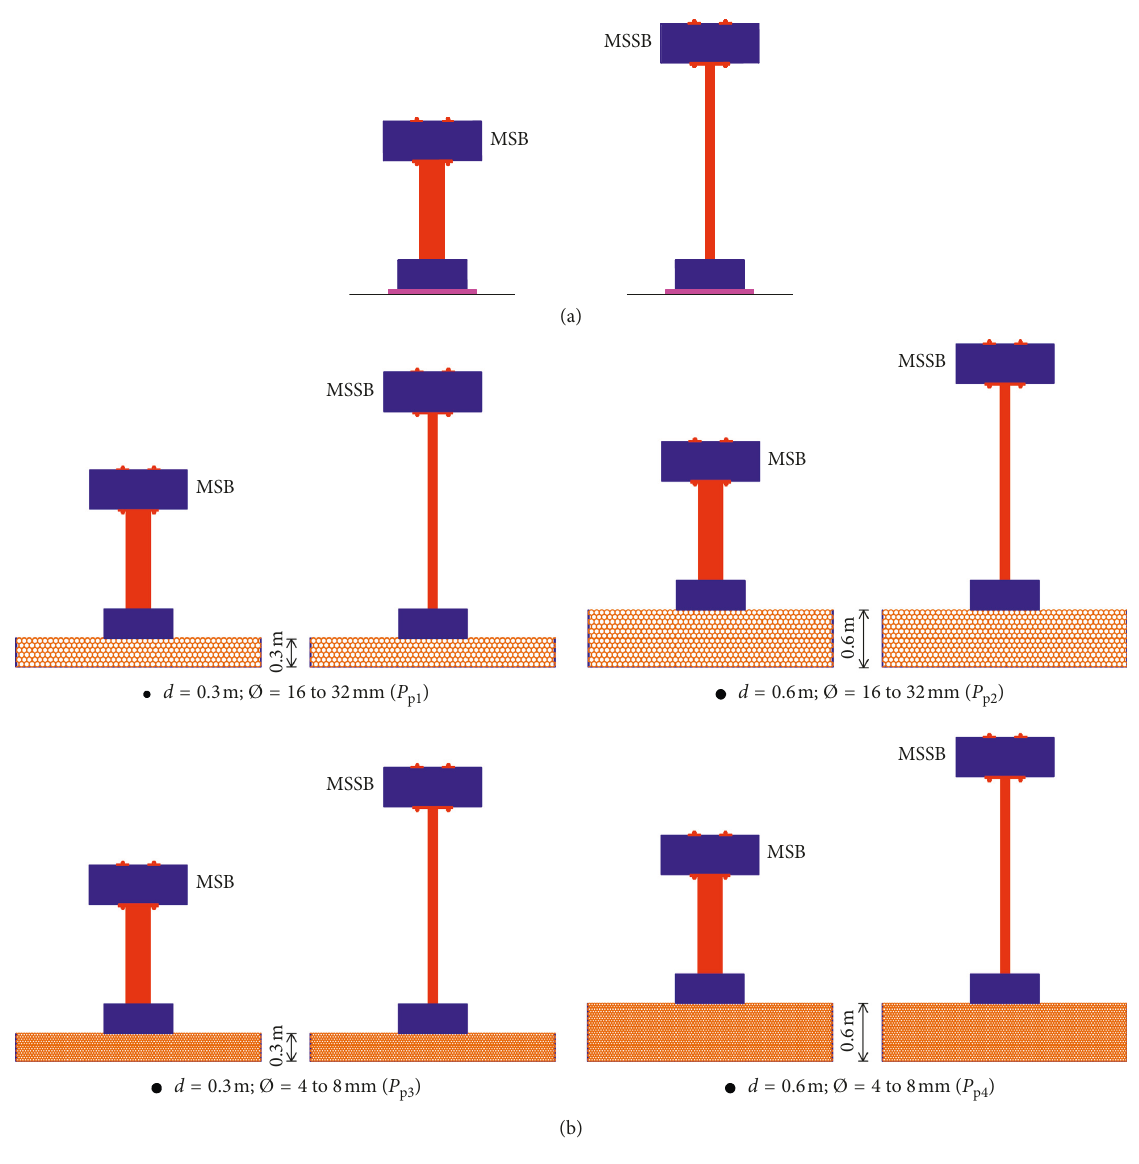
Figure 5: Tested samples. (a) Rigid base ( P